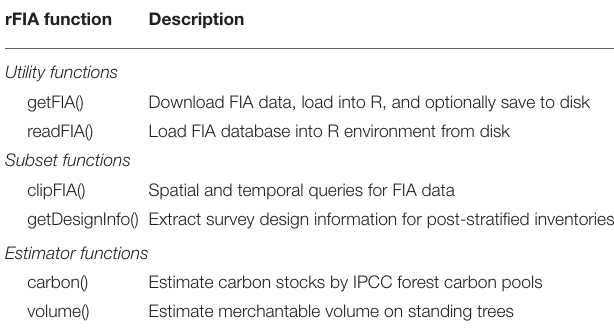
TABLE 1 | Descriptions of core rFIA functions used in case studies presented herein. rFIA